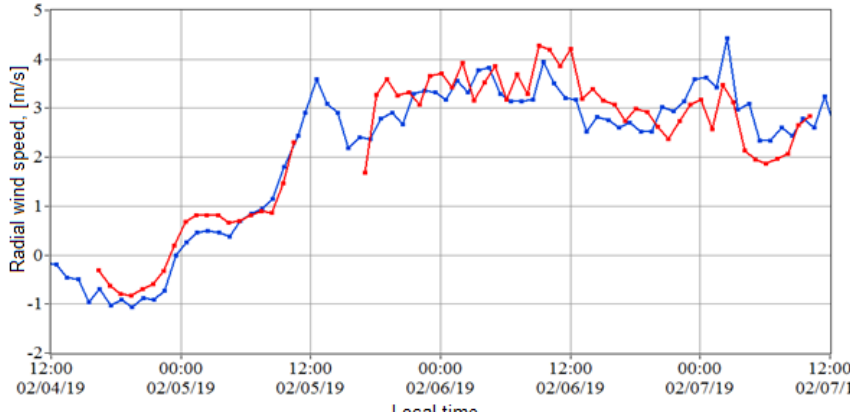
Fig.6. Time dependencies of radial wind speed at the distance of 442 m from lidars. Red line – IAO-lidar, blue line – "Stream Line" lidar. Average time is one